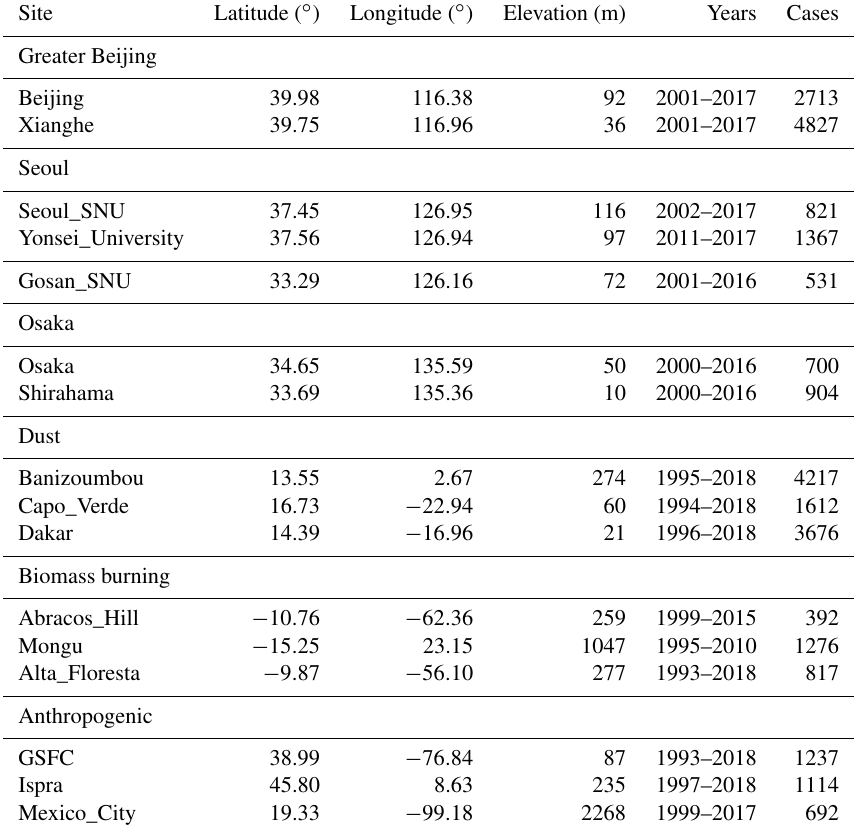
Table 1. Geographical and retrieval information for each AERONET site used in this study, along with some references for each aerosol type. The number of cases refers to observations for which SSA and PLDR are available in the AERONET database.